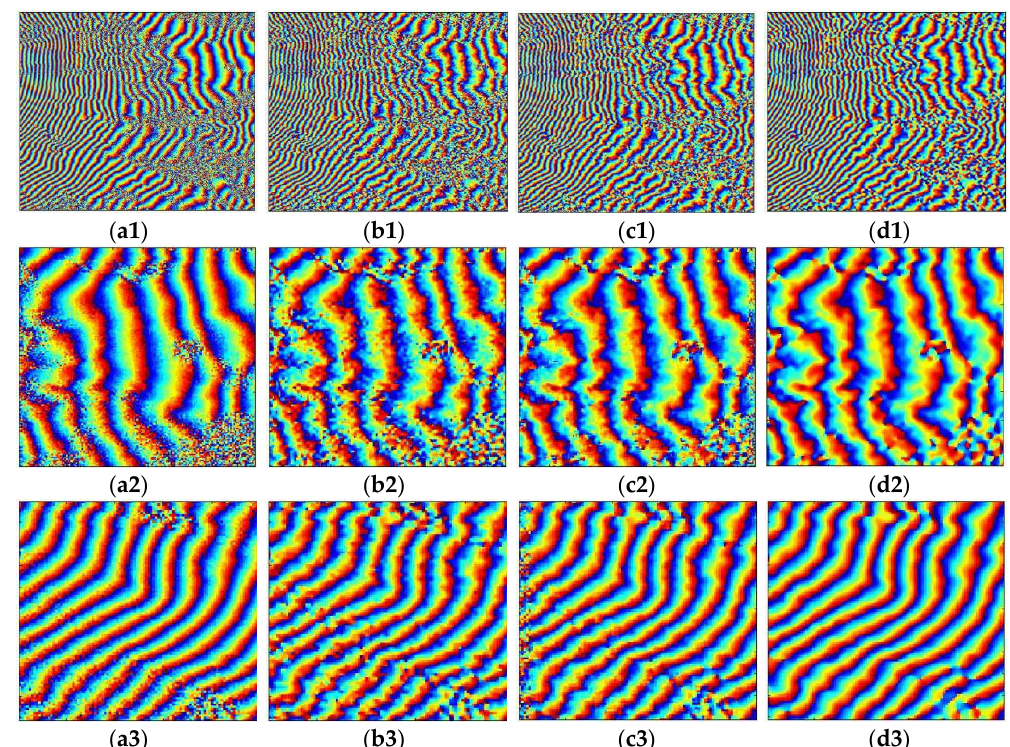
Figure 8. Filtering results of ( a1 ) Goldstein filter; ( b1 ) wavelet filter; ( c1 ) Lee filter; and ( d1 ) the proposed filter; ( a2 – d2 ) Close-up of results of area A in Figure 7; ( a3 – d3 ) Close-up of results of area B in Figure 7. (Unit: rad).